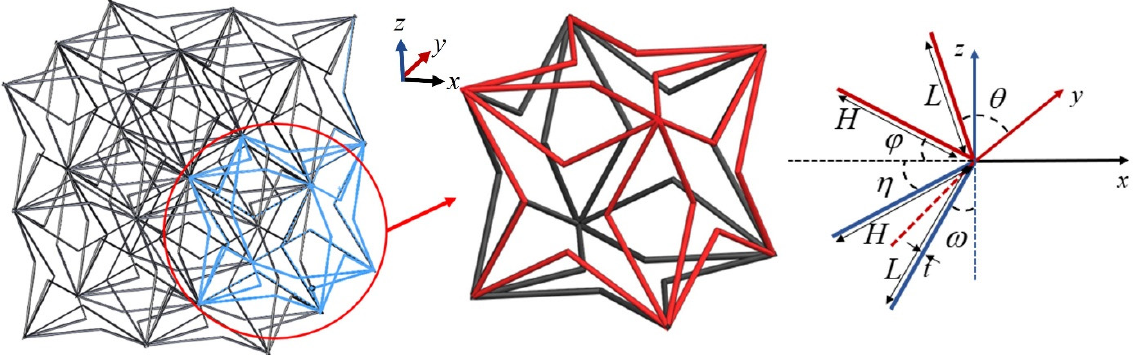
Figure 2. The layout of the novel zero Poisson’s ratio honeycomb and geometric parameters of a unit cell.